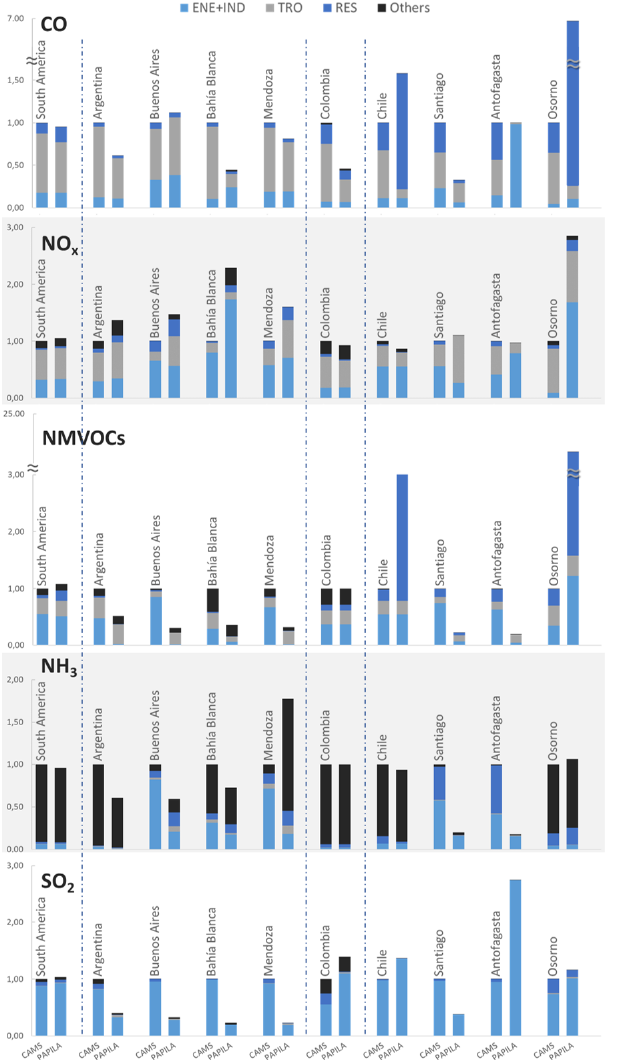
Figure 3. Normalized breakdown of PAPILA emissions compared with the CAMS inventory by domain and category group for 2015.